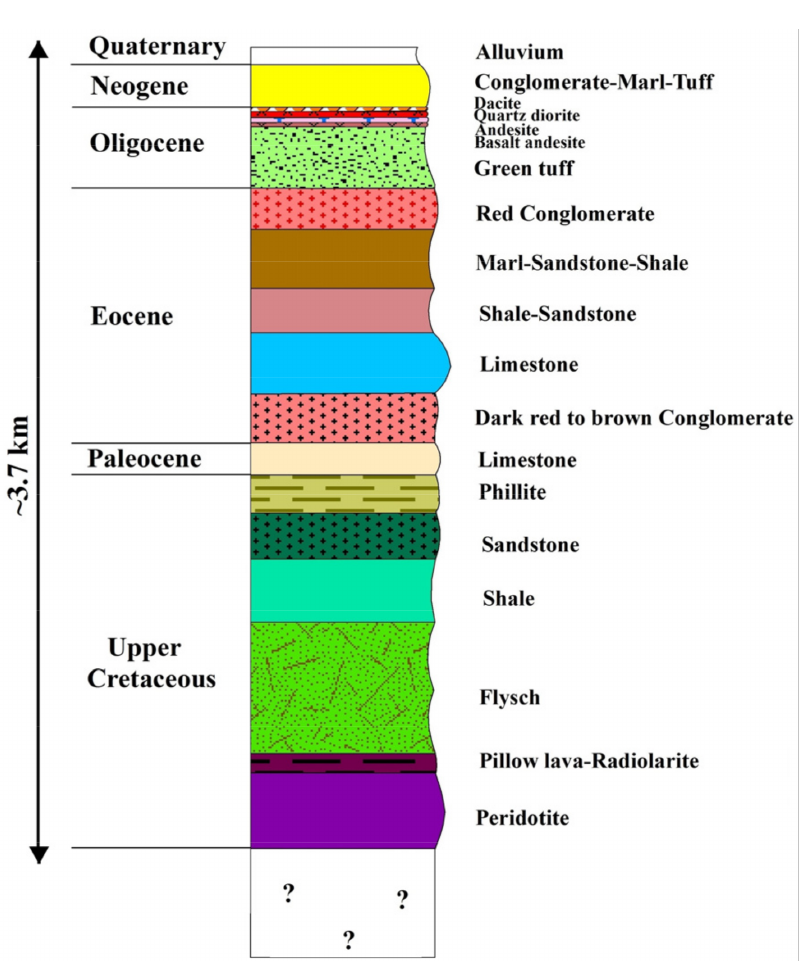
Figure 3. Synthetic log of the Shekarab Mountains. Their surface expansion is shown on the geological map of Figure